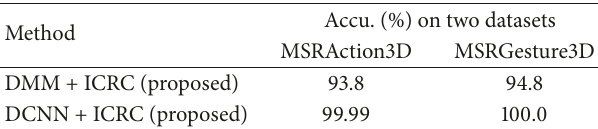
Figure 5: Recognition rates (unit: %) of 12 classes in MSRGesture3D dataset. Table 2: Recognition accuracies (unit: %) comparison of DMM + ICRC and DCNN + ICRC on the MSRAction3D dataset and MSRGesture3D